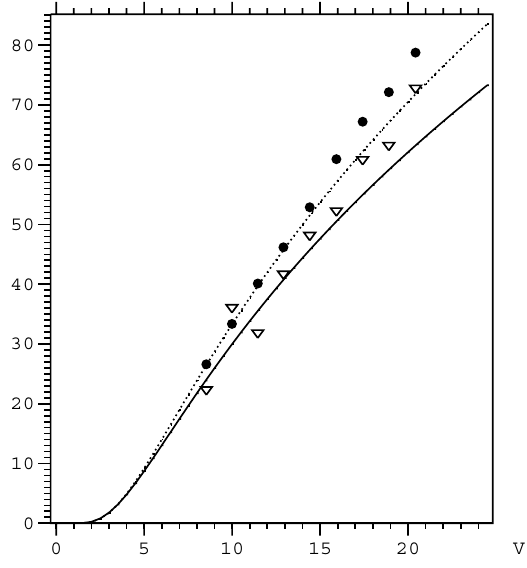
Fig. 6. Force per unit length from 2-D PIC simulation as a function of wire voltage V 0 compared with model prediction. Force calcu- lated from electric field at wire (method 1, triangles), from parti- cle momentum balance (method 2, dots), force from and Eq. (8) (solid) and force from Eq (8) multiplied by 0.6 and T e replaced by q T 2 e + ( 30eV ) 2 (dotted). Motivation for dotted line expression is given in connection with Fig. 9. In each case the risetime was 5ms, the run was continued until 40ms and the forces were averaged at